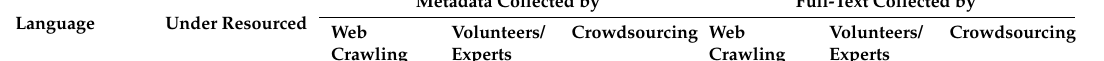
Table 2. Collected knowledge about the Adventures of Huckleberry Finn translations. Language Under